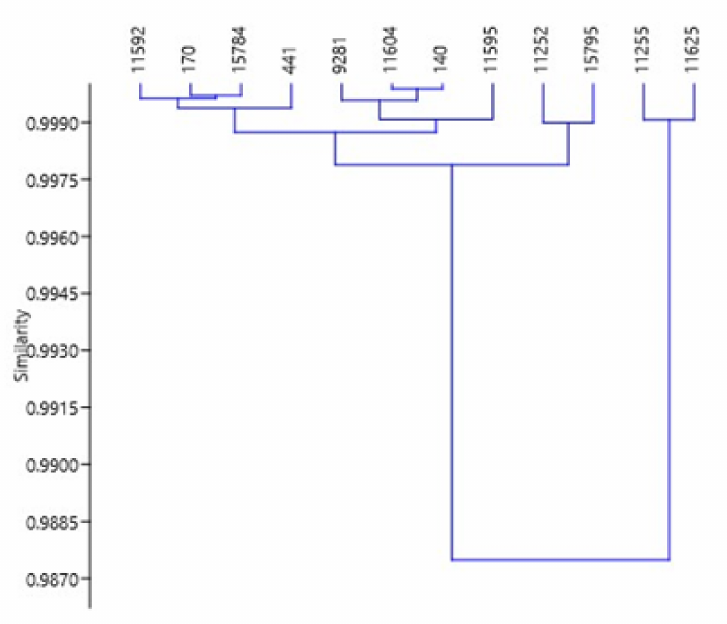
Figure 2. Similarity plot of di ff erent S. scabra accessions for all parameters